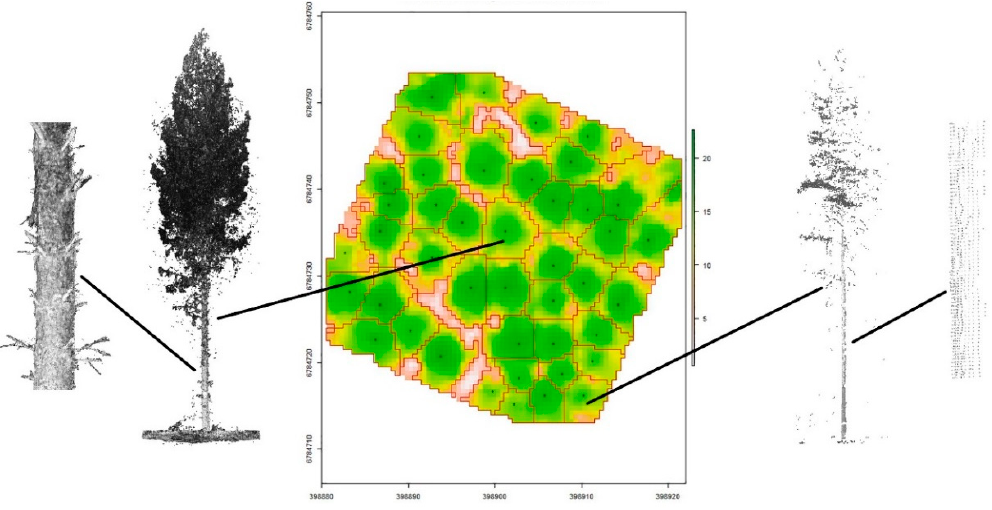
Figure 3. Filtered canopy height model based on terrestrial laser scanning point cloud of a plot with segments and detected trees to illustrate the quality of the point cloud near the plot center (left) and at the border (right) in characterizing individual trees.